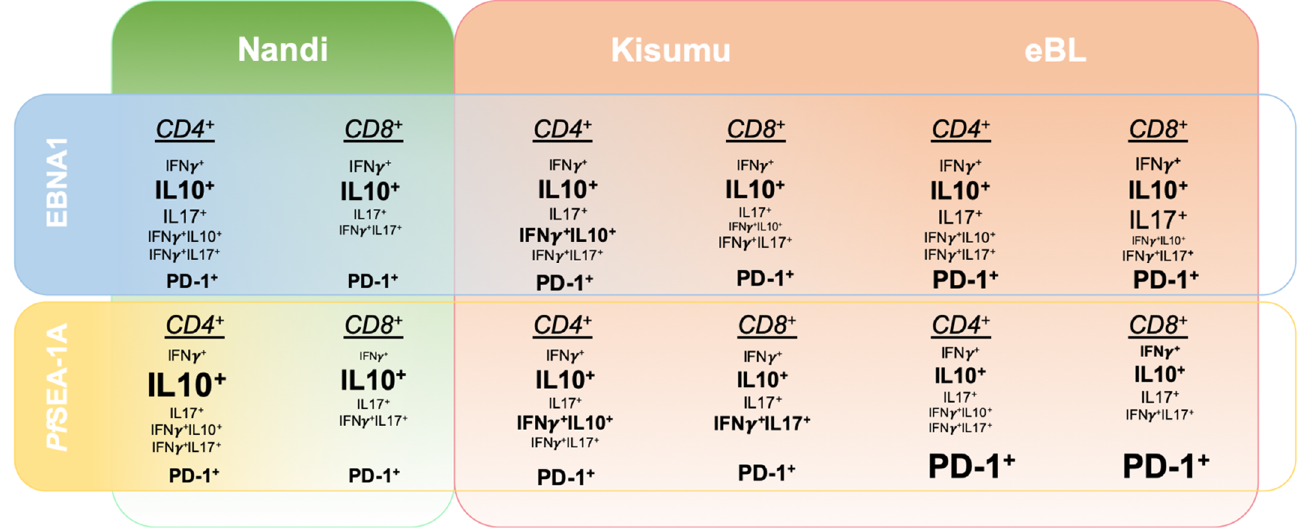
Figure 8. Summary of relative cytokine expression patterns to EBNA1 compared to a malaria antigen, Pf SEA-1A across three groups of children: Nandi, low malaria exposure; Kisumu, high malaria exposure; and eBL cancer patients, high malaria exposure. The summary is based on the 2D gating strategy from FlowJo and unbiased Boolean gating in SPICE.